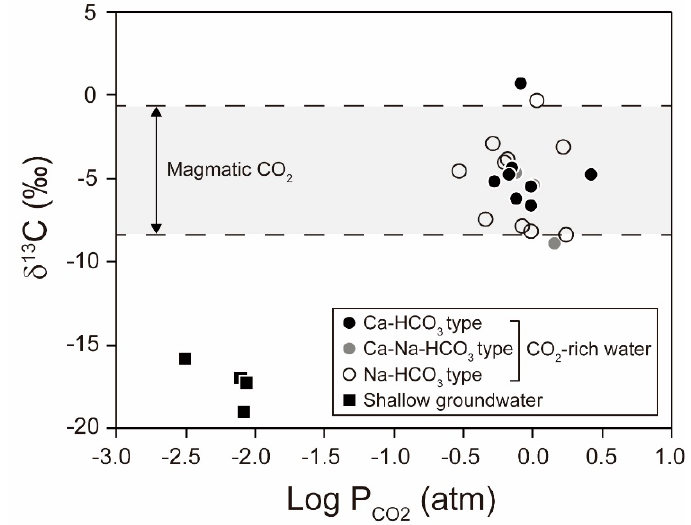
Figure 2. Plots of log P CO2 versus δ 13 C values for water samples from the Gangwon Province of South Korea. The water types were classified based on the Piper diagram (see below). The sources of data used are shown in Tables 1 and 3.